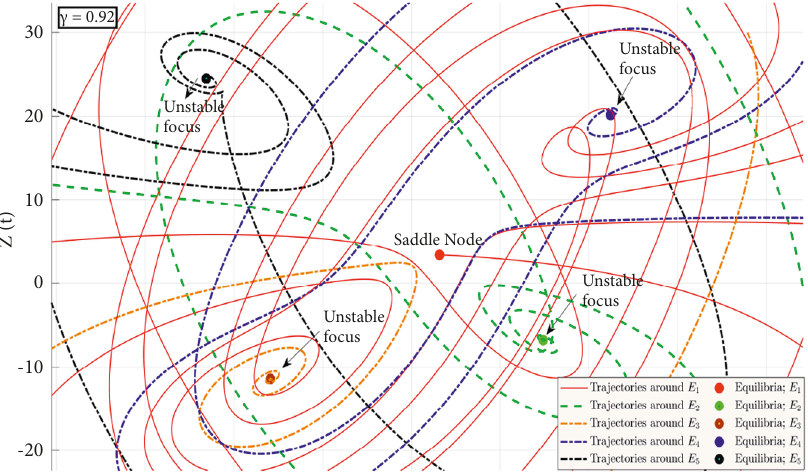
Figure 4: Trajectories of system (4) around equilibrium points.